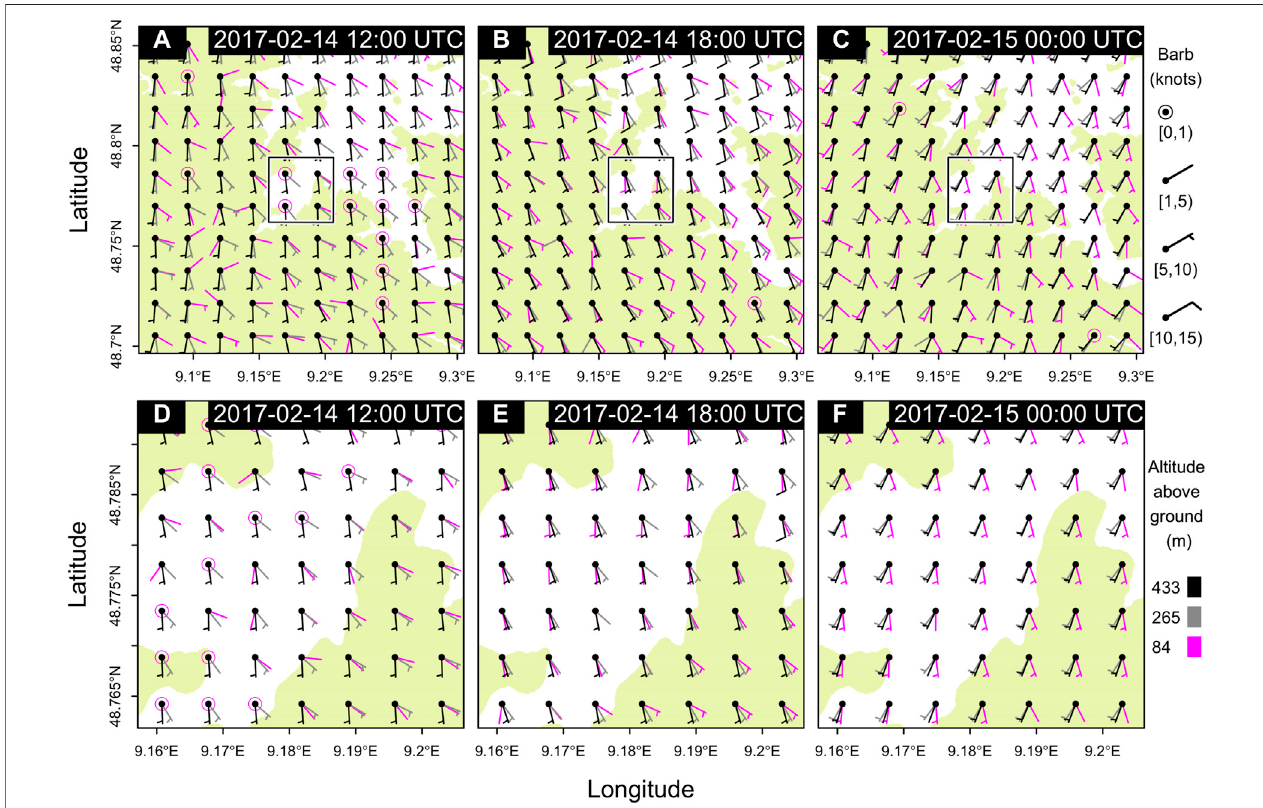
FIGURE 10 | The spatial mean modelled velocity fi elds at three model altitudelevels and at 12:00, 18:00 on 14 February 2017 and 00:00 on 15 February 2017 are show for the Stuttgart area (top) and Stuttgart City Centre (bottom), corresponding to the areas shown in Figures 1A,C , respectively. Topography with an elevation exceeding 300 m a.s.l. is highlighted in the background in light